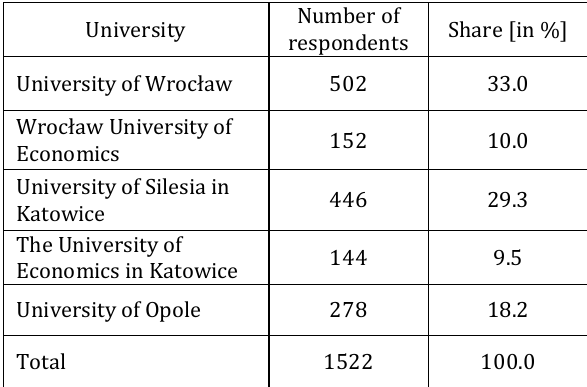
Table 1. The number of respondents and their share in